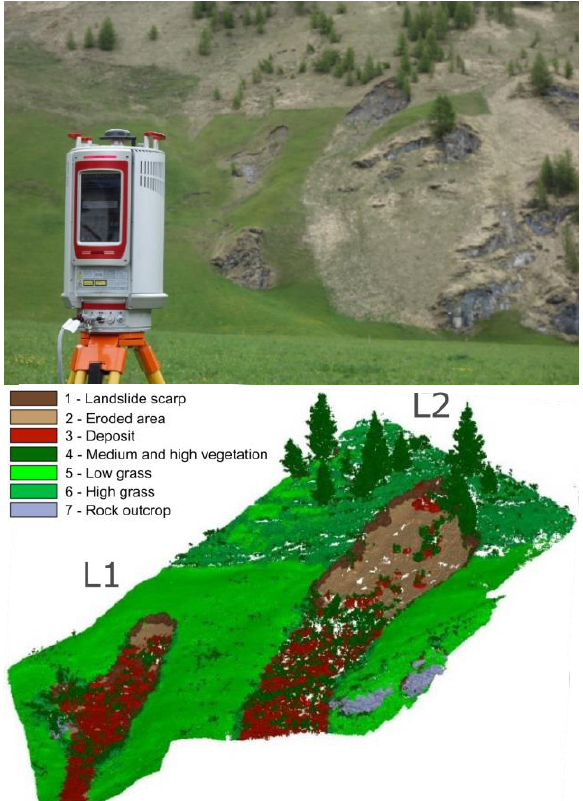
Figure 1. Terrestrial laser scanning at the test site (top) and a labelled point cloud with two landslides L1 and L2